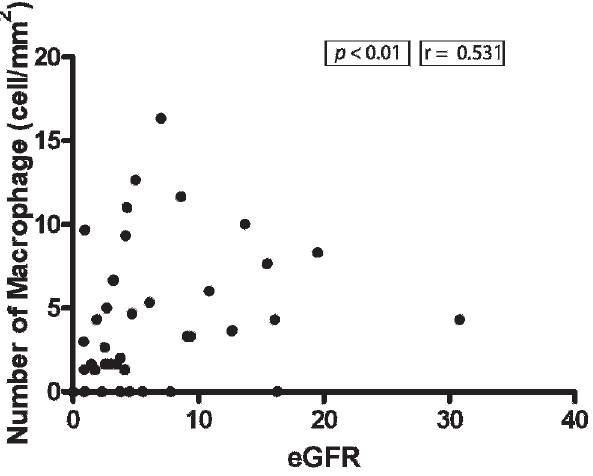
Figure 5 - The correlation between the number of macrophages in the tubulointerstitial area and annual decrement of eGFR calculated after three years of follow-up. Figure 6 - The renal survival of patients with IgAN (n=62) as a